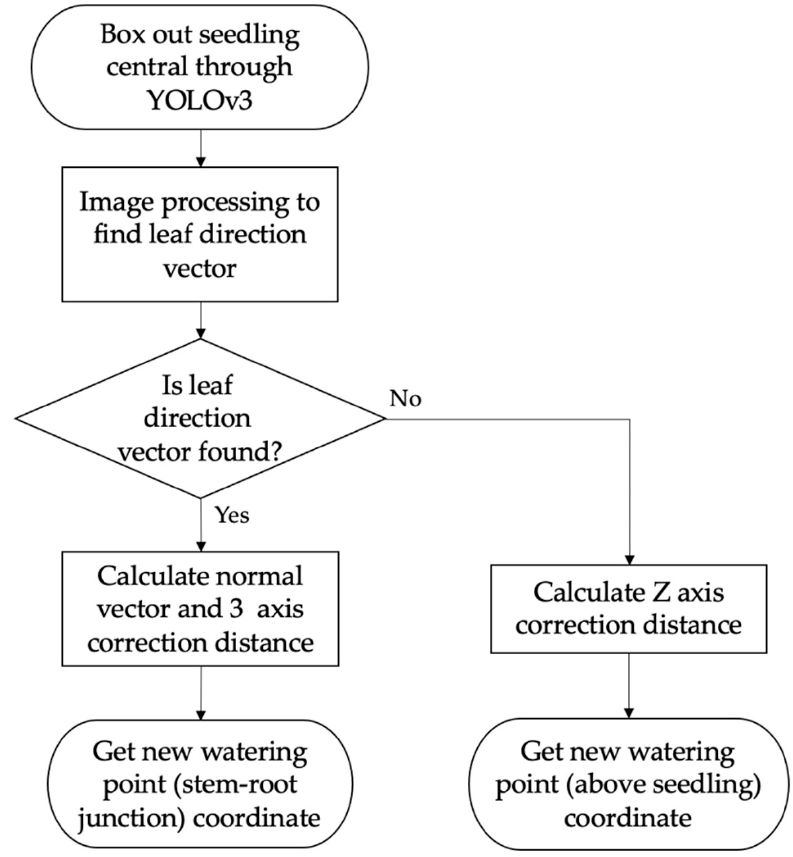
Figure 13. Correction process of watering point.